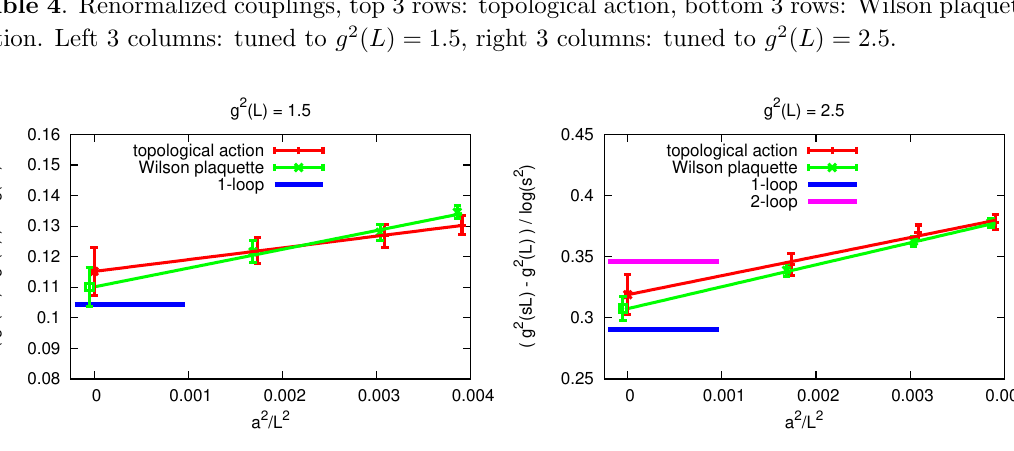
Figure 6 . Continuum extrapolations of the discrete (cid:12) -function at g 2 ( L ) = 1 : 5 (left) and g 2 ( L ) = 2 : 5 (right). The Wilson plaquette data is displaced slightly for better